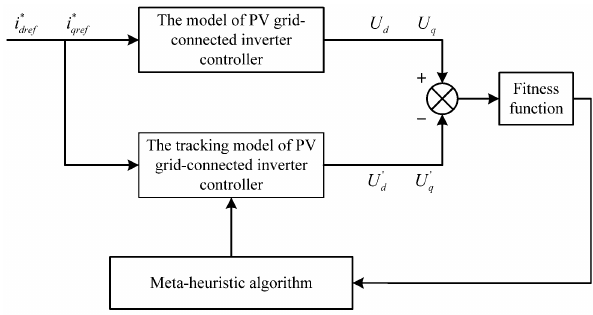
Figure 11. Schematic diagram of controller parameter identification.